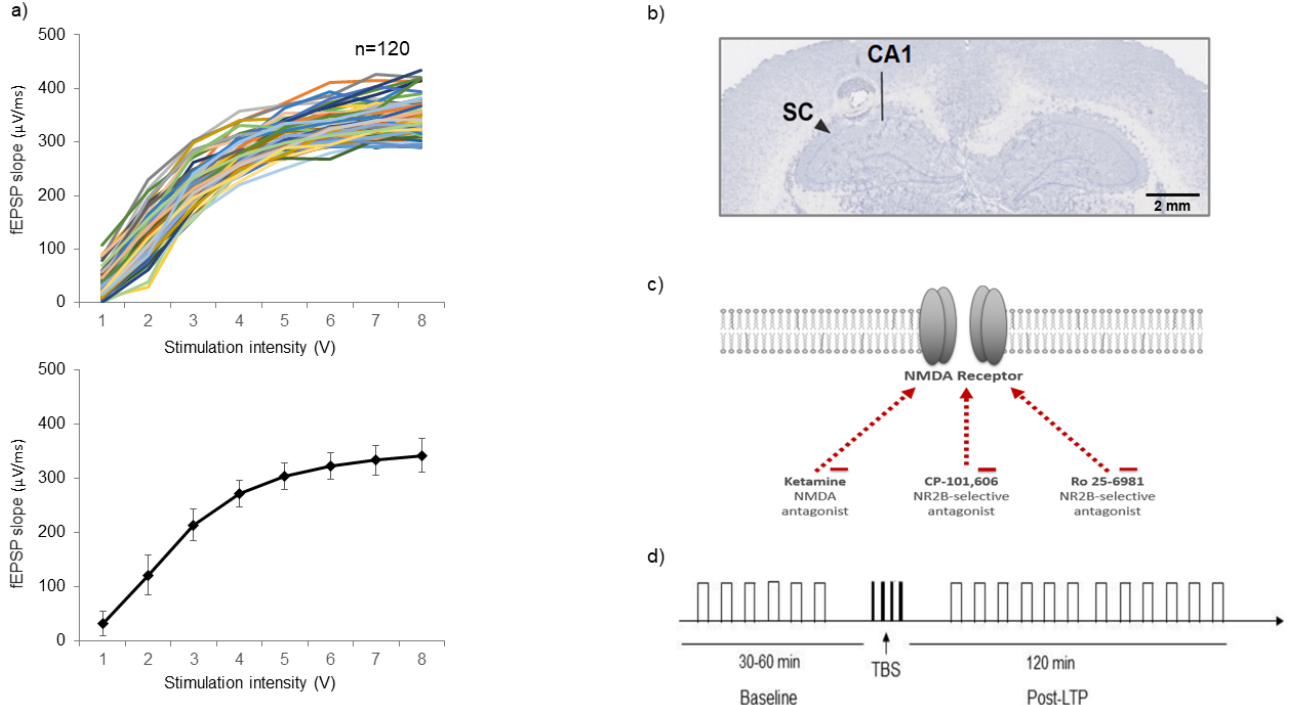
Figure 1. ( a ) Spaghetti plot of individual input/output curves and average values. Historical individual fEPSP slopes ( n = 120) lie between 280 and 430 µ V/ms at 200 µ s stimulus duration and the calculated stimulus fit between 1.75 and 3.25 V. The average calculated fEPSP slope is 341.97 ± 31.24 µ V/ms. ( b ) Stained and scanned slide for verification of the stimulating and recording electrode’s positioning (stimulation electrode at the ipsilateral SC pathway, recording electrode at the CA1 region of the hippocampus, more specifically in the stratum radiatum layer). ( c ) Pharmacological compounds used to study LTP response in SD rats, including ketamine, CP-101606 and Ro 25-6981. ( d ) Schematic presentation of the TBS electrical stimulation protocol that induce LTP at the SC-CA1 synapses in anesthetized rats.